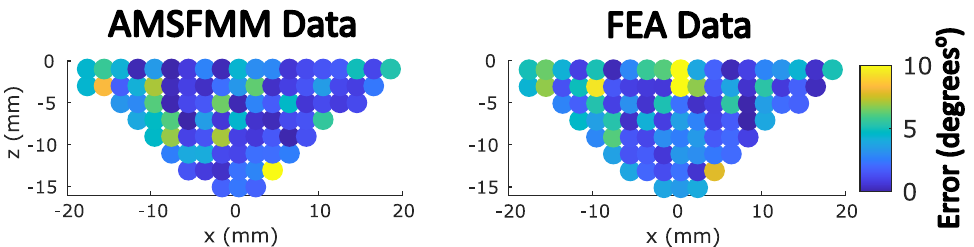
Figure 8. Comparison of absolute error (in degrees ◦ ) between predicted and true grain orientations for Test Model 1 (as in Figure 6) using the pulse-echo transducer array configuration. The error distributions are shown for case of the inverse crime, with AMSFMM generated data ( left ), and for FEA generated data ( right